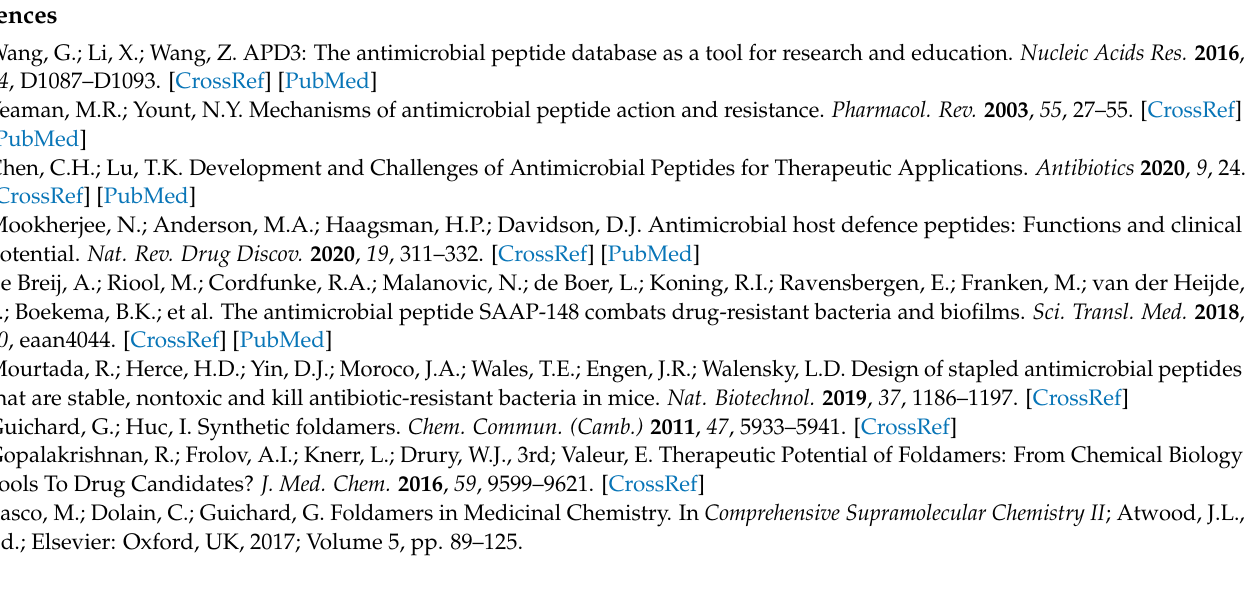
Figure S1. Structure of OL-5 , RP-HPLC chromatogram of pure compound (30% to 65% of CH3CN, 0.1%TFA in 20 min) and MS analysis; Figure S2. Structure of OL-6 , RP-HPLC chromatogram of pure compound (5% to 80% of CH3CN, 0.1%TFA in 10 min) and HRMS analysis; Figure S3. Structure of OL-7 , RP-HPLC chromatogram of pure compound (5% to 80% of CH3CN, 0.1%TFA in 10 min) and HRMS analysis; Figure S4. Evaluation of Minimal Inhibitory Concentrations (MIC) of five foldamers towards S. aureus 25923; Figure S5. Evaluation of Minimal Inhibitory Concentrations (MIC) of five foldamers towards MRSA; Figure S6. Evaluation of Minimal Inhibitory Concentrations (MIC) of five foldamers towards P. aeruginosa ; Figure S7. Evaluation of Minimal Inhibitory Concentrations (MIC) of five foldamers towards E. coli; Figure S8. Structure of OL-5 analogue [ Lys u 2, 5, 7 ] OL-5 and of DIM-3 , the dimer of OL-3 ; Figure S9. LDH and MTS assays performed on the human cell line MDA-MB-231; Figure S10. Evaluation of Minimal Inhibitory Concentrations (MIC) of five foldamers towards C. albicans; Figure S11. Antifungal activity in µ g/mL of Voriconazole evaluated on Aspergillus fumigatus